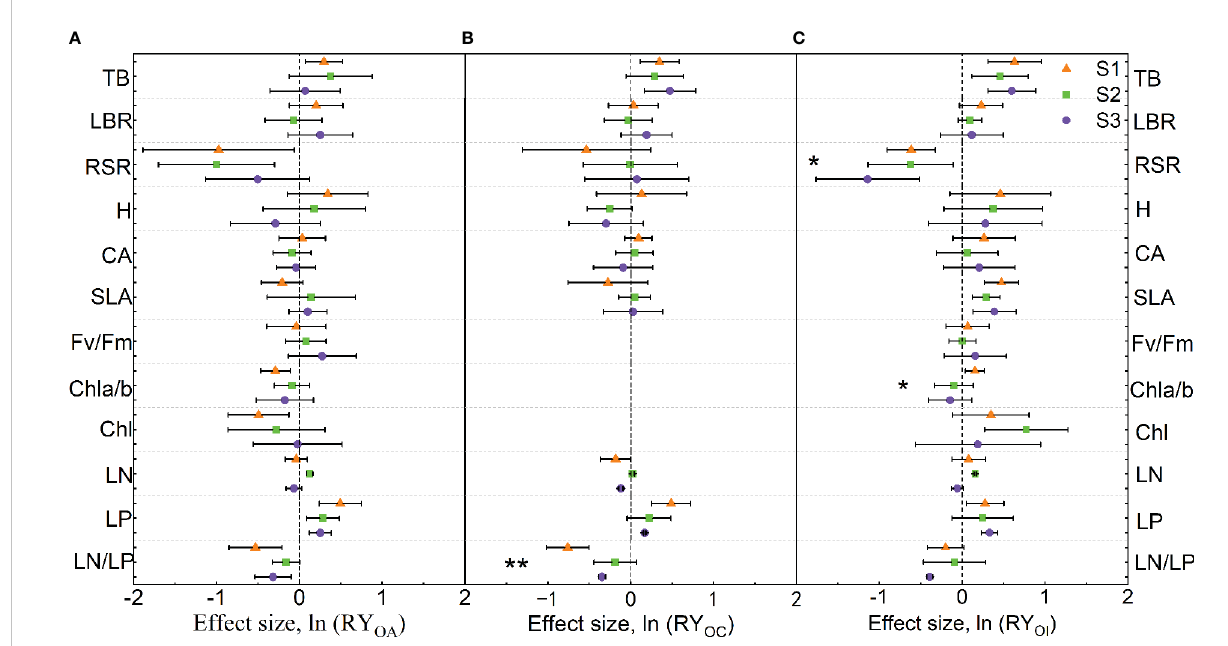
FIGURE 3 Effect sizes of mixture plantation (biological interaction) with native species ( Artemisia argyi , Chenopodium album , and Inula japonica ) on invasive species ( Oenothera biennis ) traits in three salinity treatments. OA, O. biennis in mixed culture with A. argyi ; OC, O. biennis in mixed culture with C. album ; OI, O. biennis in mixed culture with I. japonica . The orange triangle illustrates the S1 treatment (control), the green square illustrates the S2 treatment (low salt treatment), and the purple circular illustrates the S3 treatment (high salt treatment). Error bars are 95% con fi dence intervals. Signi fi cant effect sizes are indicated by con fi dence intervals that do not overlap zero. The asterisk in the fi gures indicates signi fi cant effects of salt stress on different functional traits of O . biennis under interspeci fi c interaction. The capital letters represent the traits of O . biennis when mixed with native species - A. argyi (A) , C. album (B) , and I. japonica (C) and when monoculture. Abbreviations have identical meanings as described in Table